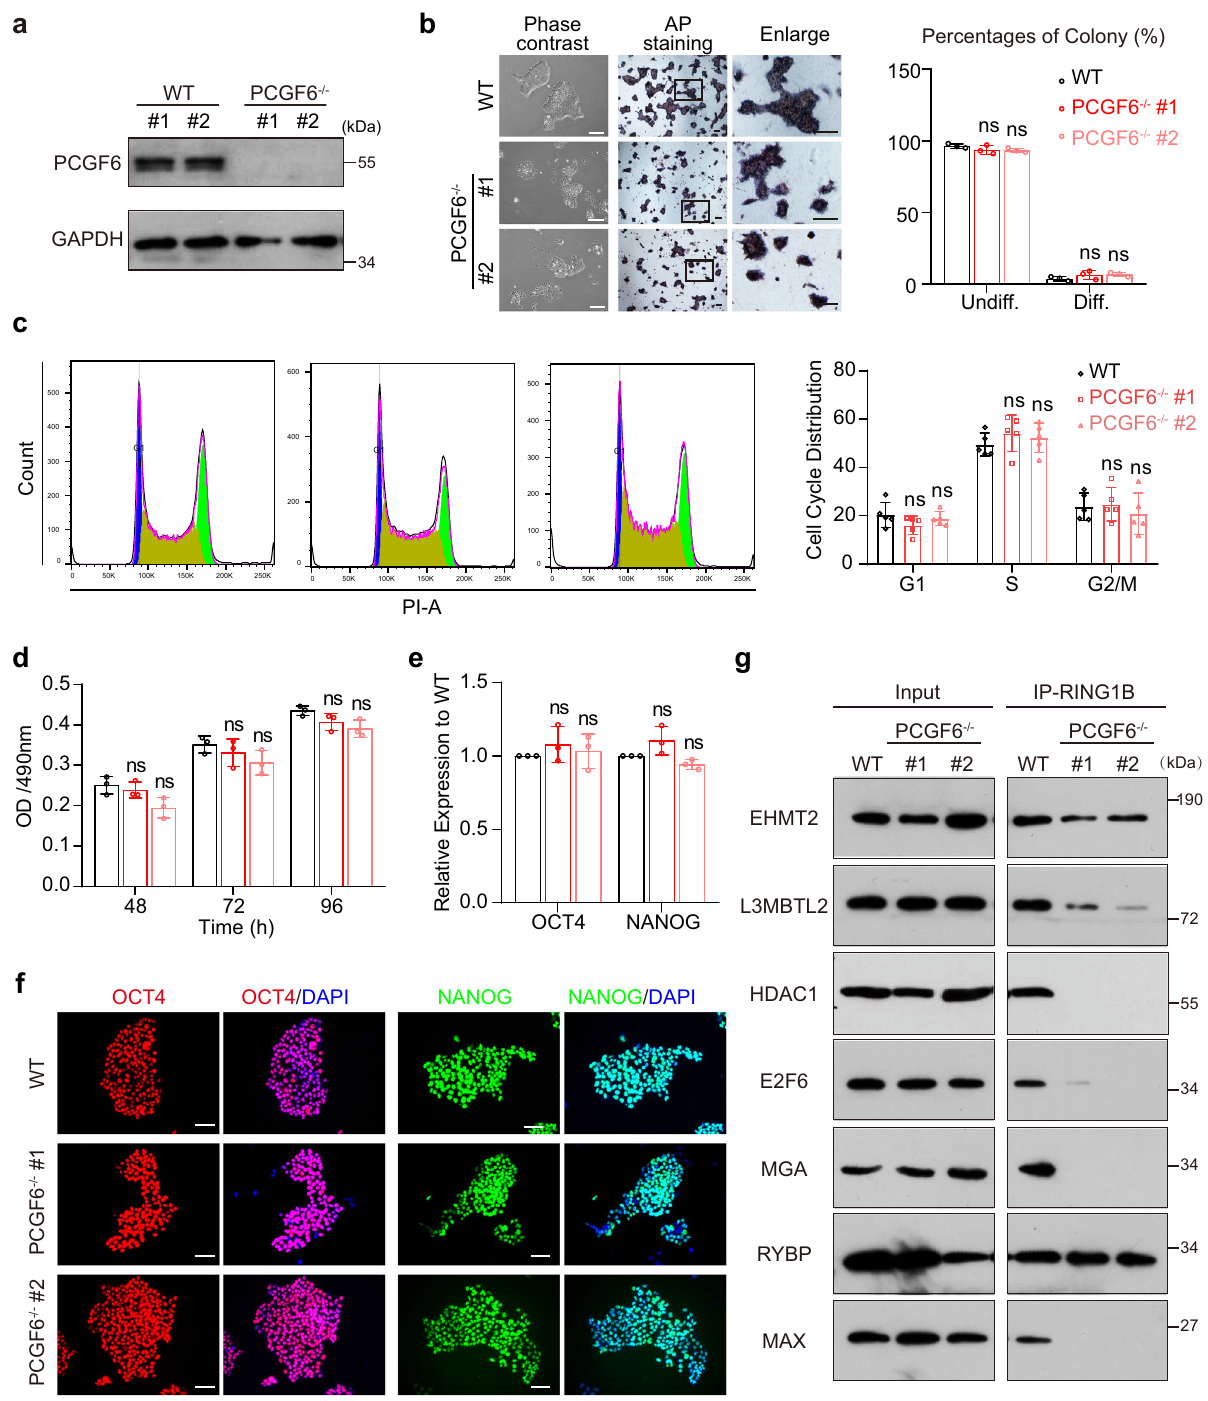
Fig. 1 | PCGF6 is dispensable for maintenance of human PSCs. a PCGF6 protein level in WT and PCGF6-KO human PSCs; GAPDH was used as loading control ( n =3). b Left: representative images showing the morphology (left panels) and alkaline phosphatase activity (right panels) of WT and PCGF6-KO human PSCs. Scale bars, 200 μ m. Right: bar graph showing the mean percentages of differ- entiated (AP-negative) and undifferentiated (AP-positive) colonies in WT and PCGF6-KO human PSCs ( n =3). ns (not signi fi cant), p >0.05 compared with WT. c Cell cycle analysis using PI staining in WT and PCGF6-KO human PSCs. The populations of different phases were calculated in FlowJo (v10.4.0) ( n =5). d MTT analysis of proliferation rate in WT and PCGF6-KO human PSCs ( n =3). e Relative expression of OCT4 and NANOG in the WT and PCGF6-KO human